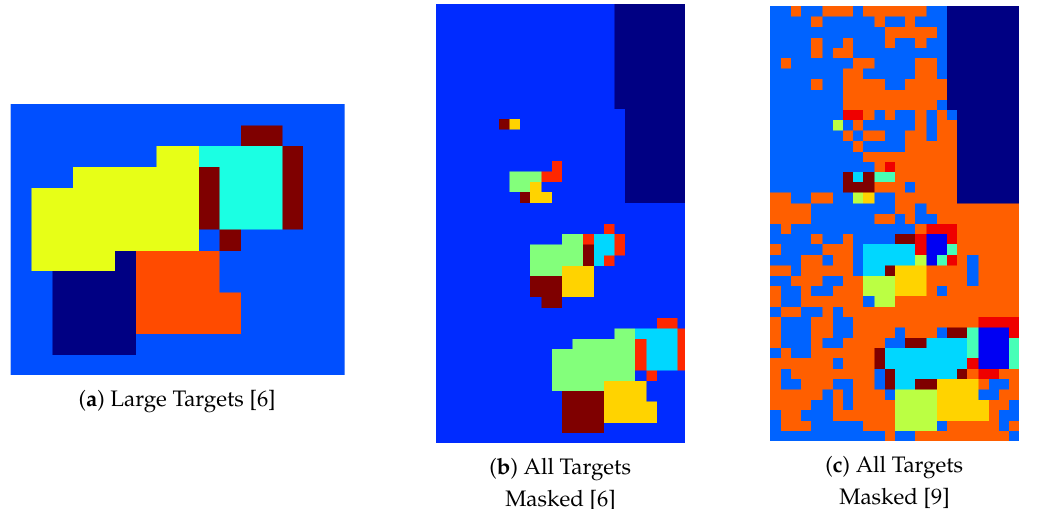
Figure 12. K-means clustering on subsets Large Targets and All Targets Masked . The number of endmembers k used in each case is shown in brackets. The centroids of each cluster are matched to the endmembers in the HySpex reference spectral library in Figure